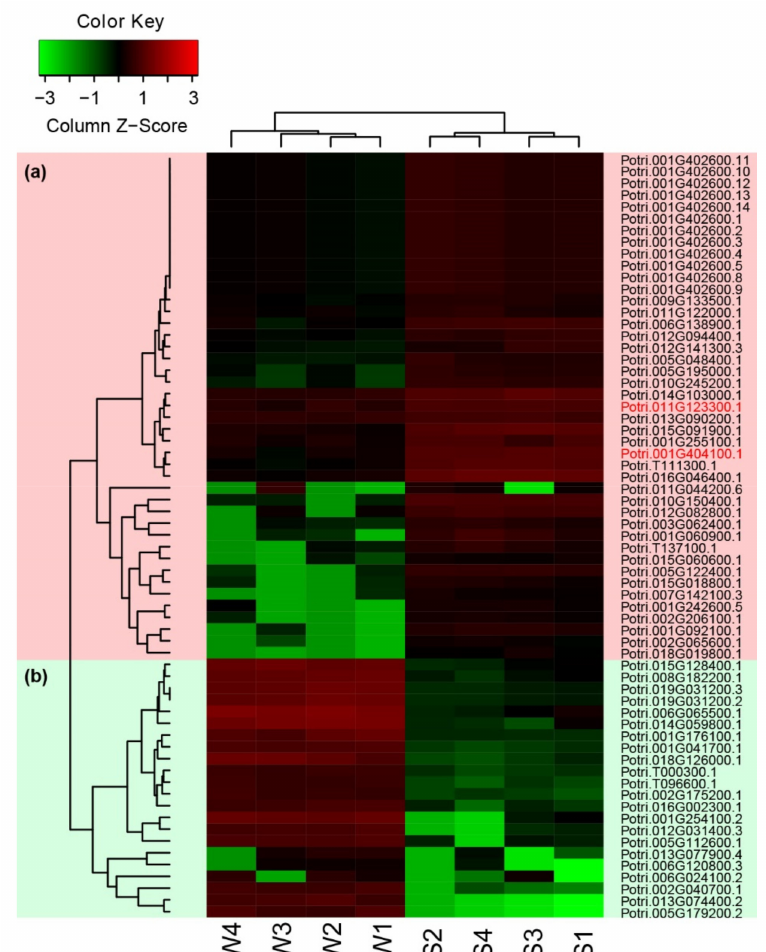
Figure 7. Heatmap and clustering of the 63 DEGs and two putative di ff erentially expressed NACs , PtNAC024 and PtNAC182 , basedonRNA-Seqindi ff erentsamplesexposedtosaltstress. ( a )Up-regulated genes are indicated with a pink background. ( b ) Down-regulated genes are indicated with an aqua background. The expression is measured as the log transformation (base 2) of the specific value (S-tested / W-control) of FPKM (fragments per kilo-base transcript per million mapped reads). The expression values were standardised by columns. Green indicates low expression and red denotes high expression. S1, S2, S3 and S4 were treated with NaCl. W1, W2, W3 and W4 were controls treated with regular water. PtNAC024 and PtNAC182 are marked with red